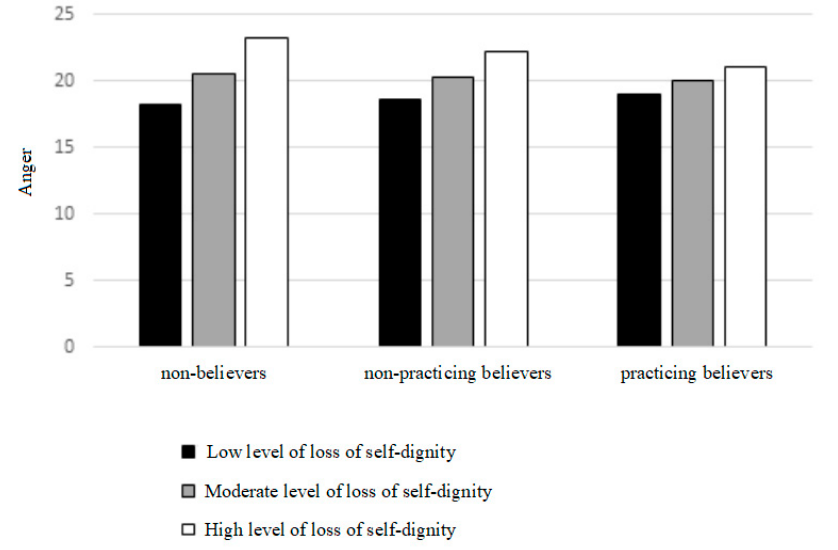
Figure 3. Simple slopes plot for the moderating role of religiosity in the relationship of loss of self-